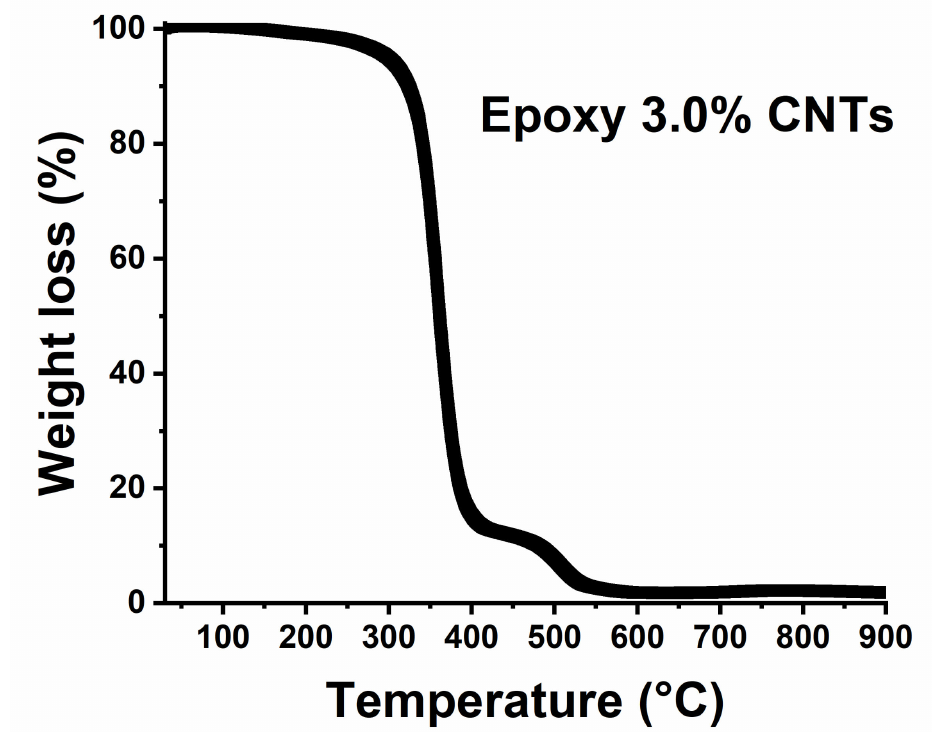
Figure 9. TGA curve of the epoxy formulation with the 3.0% by weight of